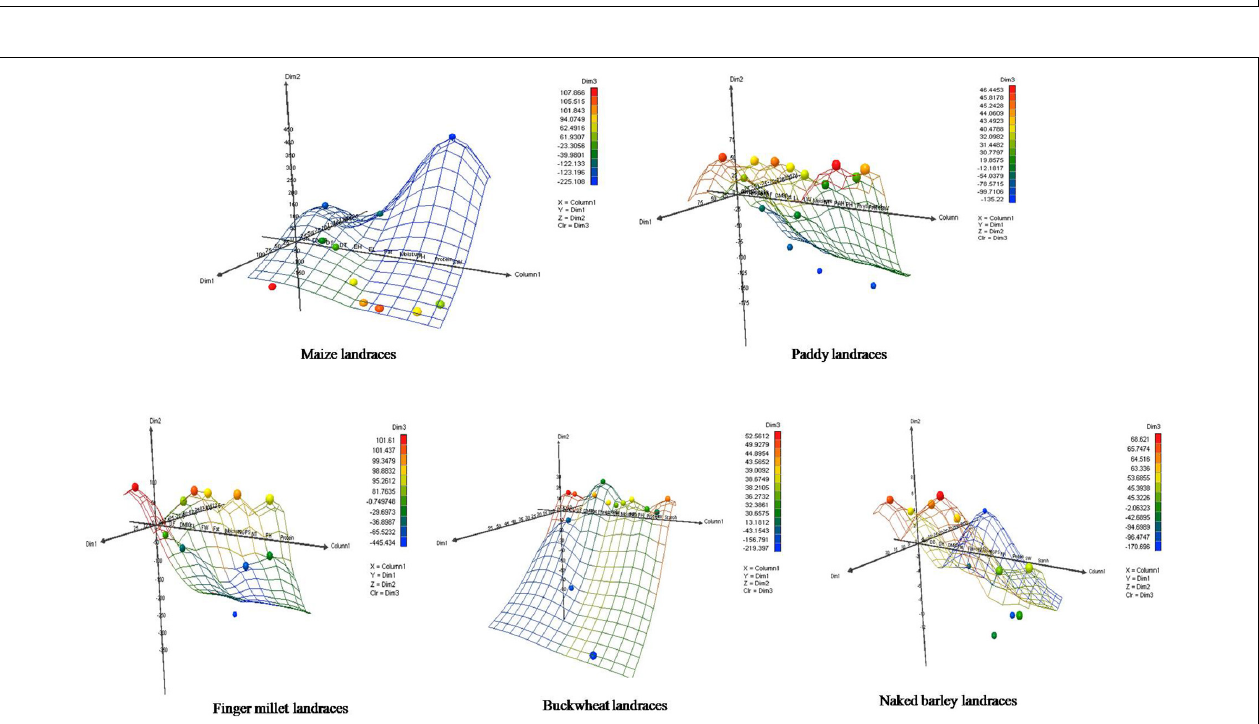
FIGURE 4 | Multidimensional scaling of agro-morphological characteristics and nutritional attributes for traditional crop landraces. X represents column 1, Y represents dimension 1, Z represents dimension 2, and Color represents dimension 3.